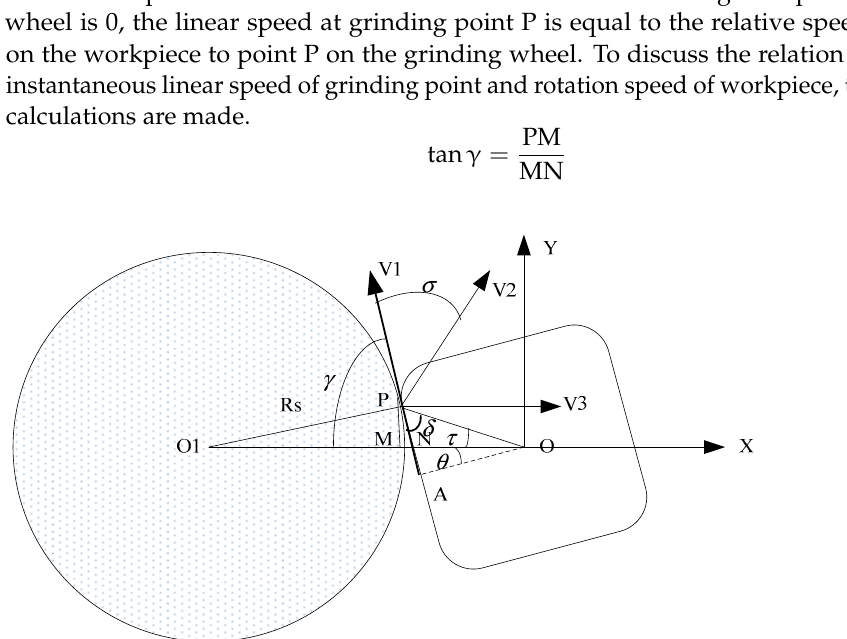
Figure 2. Diagram of grinding model.